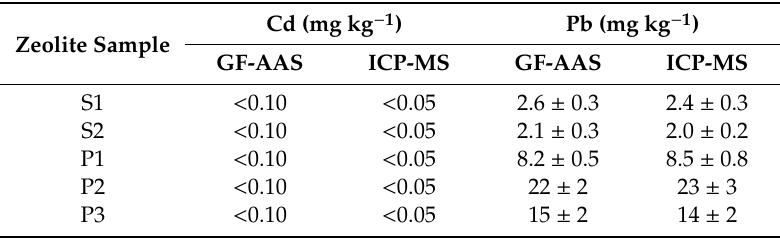
Table 5. Concentrations of total Cd and Pb (mg kg − 1 ) measured in zeolite samples by GF-AAS and ICP-MS after sample digestion ( n = 6 parallel measurements). Legend: – results presented as mean ± expanded uncertainty, < 0.10 and < 0.05–below limits of quantification (LoQ) for GF-AAS and ICP-MS,